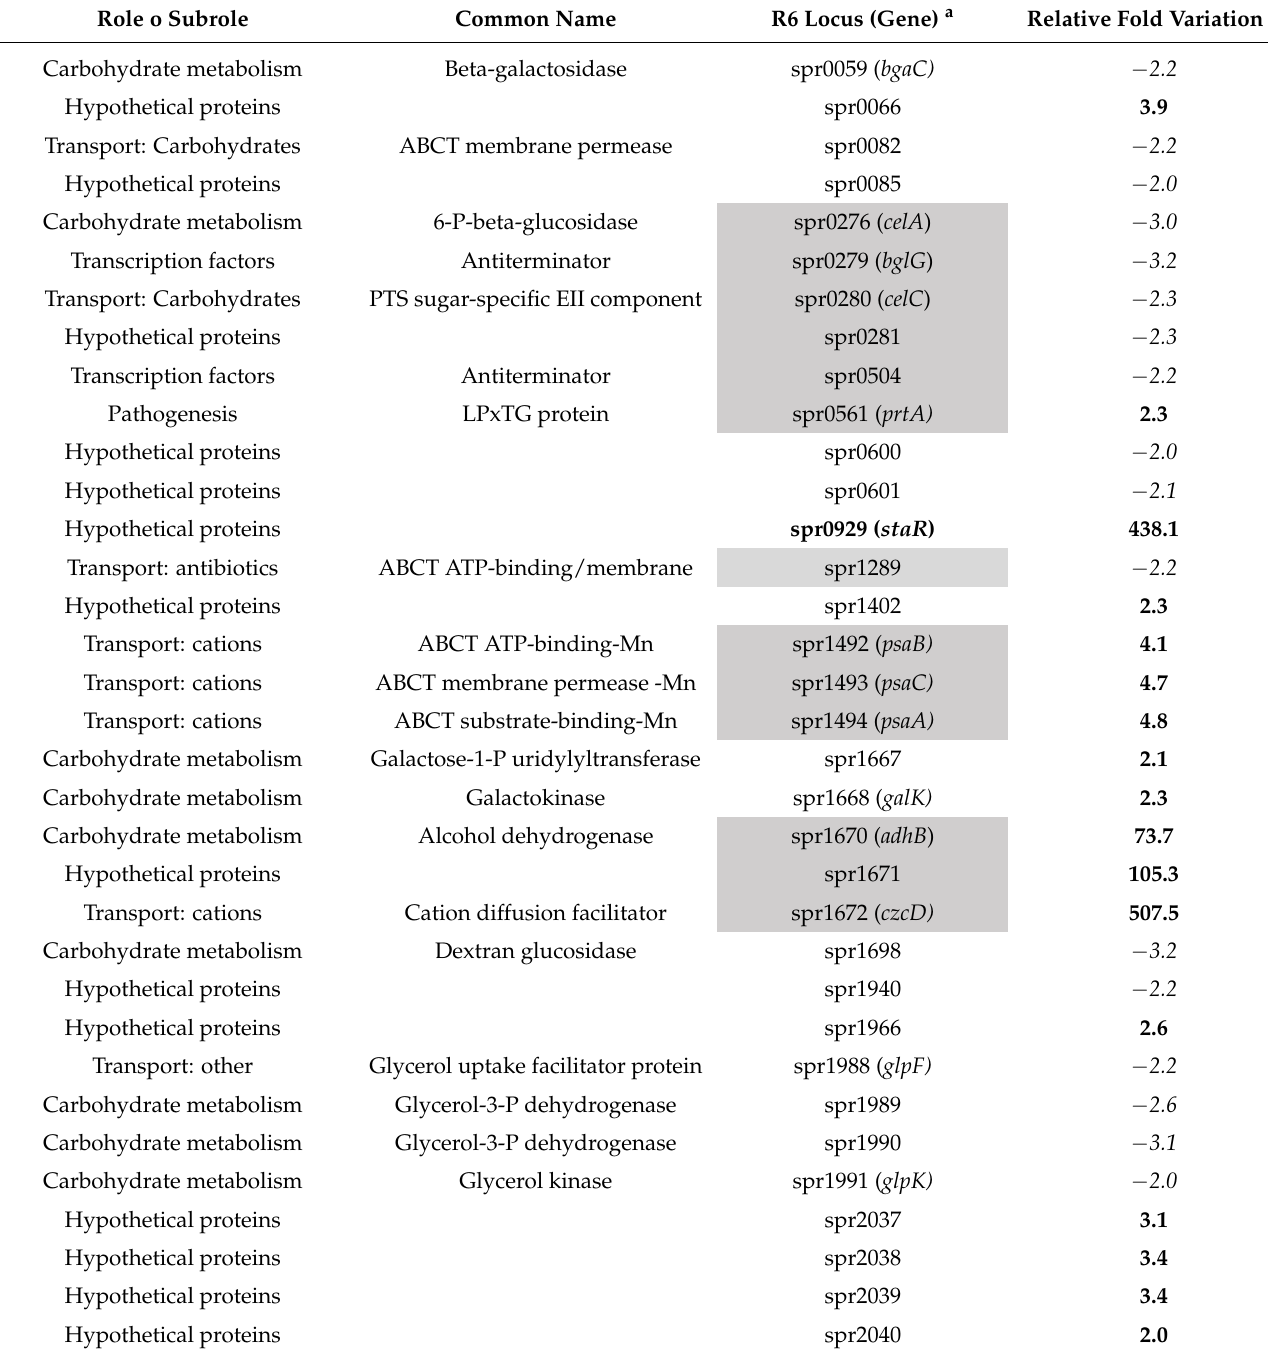
Table 1. DEGs detected in ∆ staR P Zn staR in the presence of ZnSO 4 versus in its absence. Cultures were grown to OD 620 nm = 0.2, diluted 50-fold in medium either without ZnSO 4 or with 150 µ M ZnSO 4 and grown to OD 620 nm =